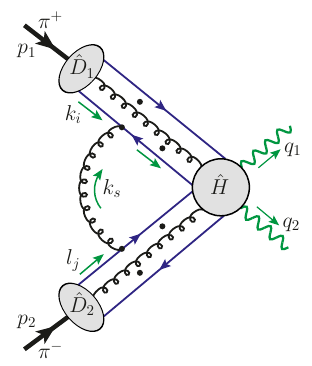
Figure 5. Sample diagram for identifying the leading soft contribution.